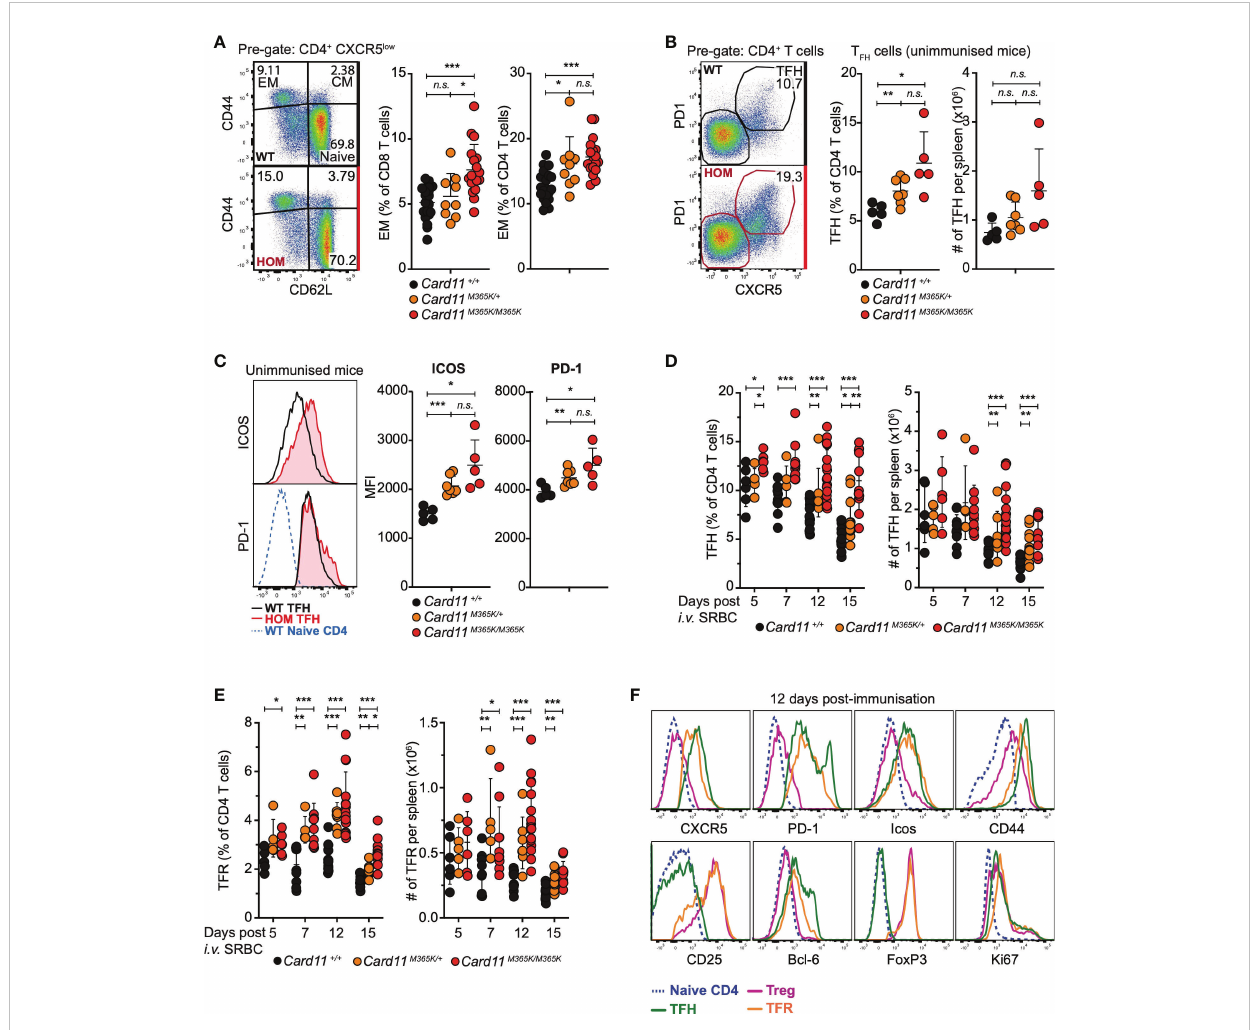
FIGURE 2 Germline GOF Card11 M365K mutation causes accumulation of effector CD4 and CD8 T cells, T follicular and T follicular regulatory T cells. (A-C) . Flow cytometric analysis of T cell populations in non-immunized mice of the indicated genotypes. (A) . Left, representative fl ow cytometric analysis and right, percentage of CD44 - CD62L + naïve, CD44 + CD62L + central memory (CM), and CD44 + CD62L - effector memory (EM) subsets among splenic CD8 or CD4 T cells. (B) . Left, representative fl ow cytometric analysis and right, percentage among CD4 T cells or total number per spleen of CXCR5 high PD-1 high follicular helper (T FH )-like CD4 T cells. (C) . Left, representative fl ow cytometric histograms showing distribution of ICOS (top) or PD-1 (bottom) fl uorescence on Card11 +/+ naïve CD4 T cells, Card11 +/+ or Card11 M365K/M365K T FH -like cells. Right, plots showing mean fl uorescence intensity (MFI) of ICOS or PD-1 on T FH -like cells from mice of the indicated genotypes. (D-F) . Flow cytometric analysis of T cell populations in mice 5, 7, 12 or 15 days post-immunization with sheep red blood cells (SRBCs). (D) . FoxP3 - CXCR5 high PD-1 high T FH cells as a percentage of CD4 + TCR b + T cells or as total number per spleen, in mice of the indicated genotypes. (E) . CXCR5 high PD-1 high CD25 + FoxP3 + T follicular regulatory (T FR ) cells as a percentage of CD4 + TCR b + T cells or as total number per spleen, in mice of the indicated genotypes. (F) . Representative fl ow cytometric histograms showing distribution of cell-surface CXCR5, PD-1, ICOS, CD44, CD25 and intracellular Bcl-6, FoxP3, Ki-67 fl uorescence in naïve CD4 (blue), T FH (green), T regulatory (T REG ; magenta) or T FR (orange) cells from Card11 M365K/M365K mice 12 days post-SRBC immunization. The histograms are also representative of results from Card11 +/+ mice and from results 7 and 15 days post-immunization. (A-E) . Statistical comparisons made by t -test, corrected for multiple comparisons using the Holm-Sidak method. Data are representative of n > 2 independent experiments with n > 4 mice per group. not signi fi cant (n.s) p > 0.05; * p < 0.05; ** p < 0.01; *** p < 0.001. (A, D, E) . Data are pooled from 3 independent